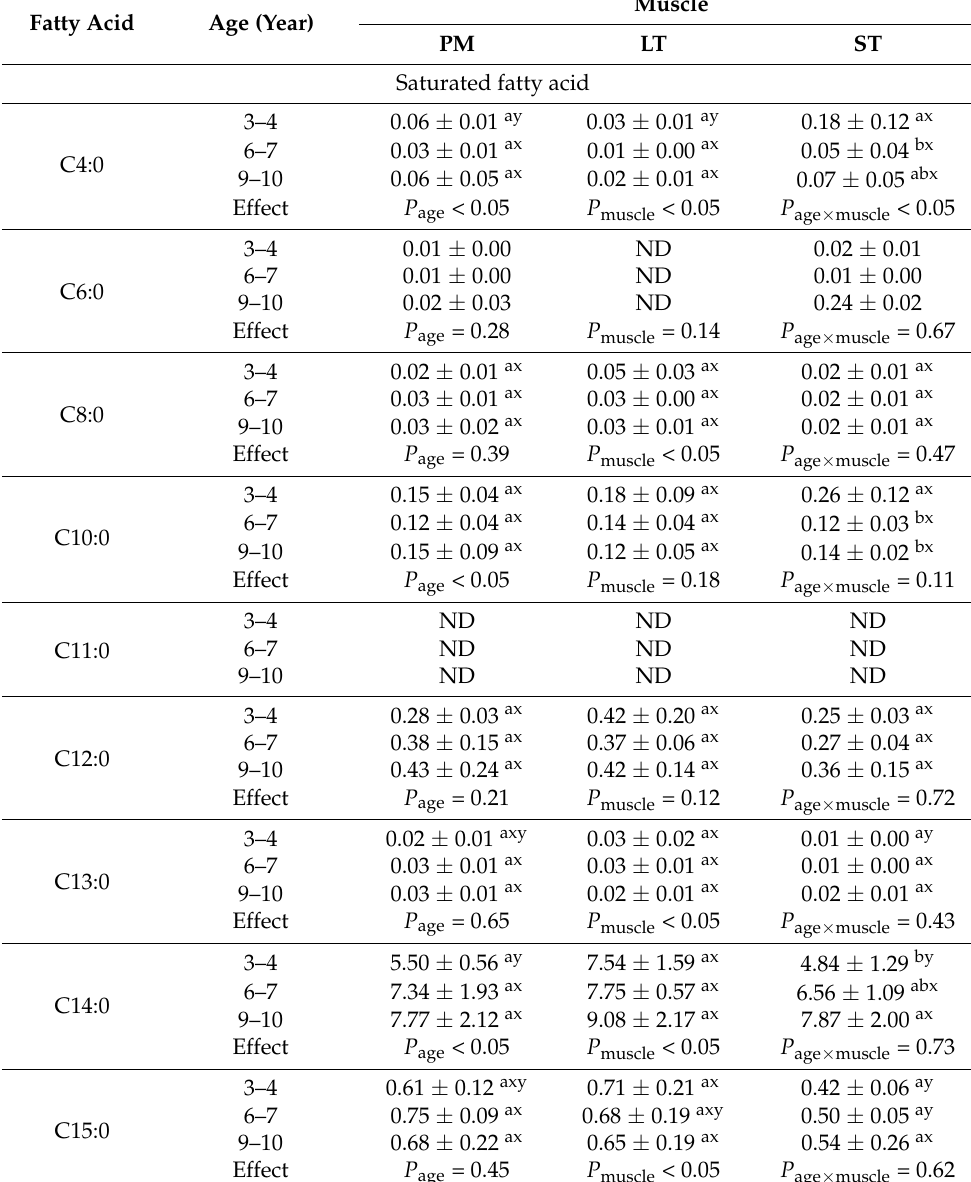
Table 4. Fatty acid composition (%) of the Psoas major (PM), Longissimus thoracic (LT), and semitendi- nosus (ST) muscle samples from Alxa Bactrian camels ( n = 5, mean ± standard error) slaughtered at three different